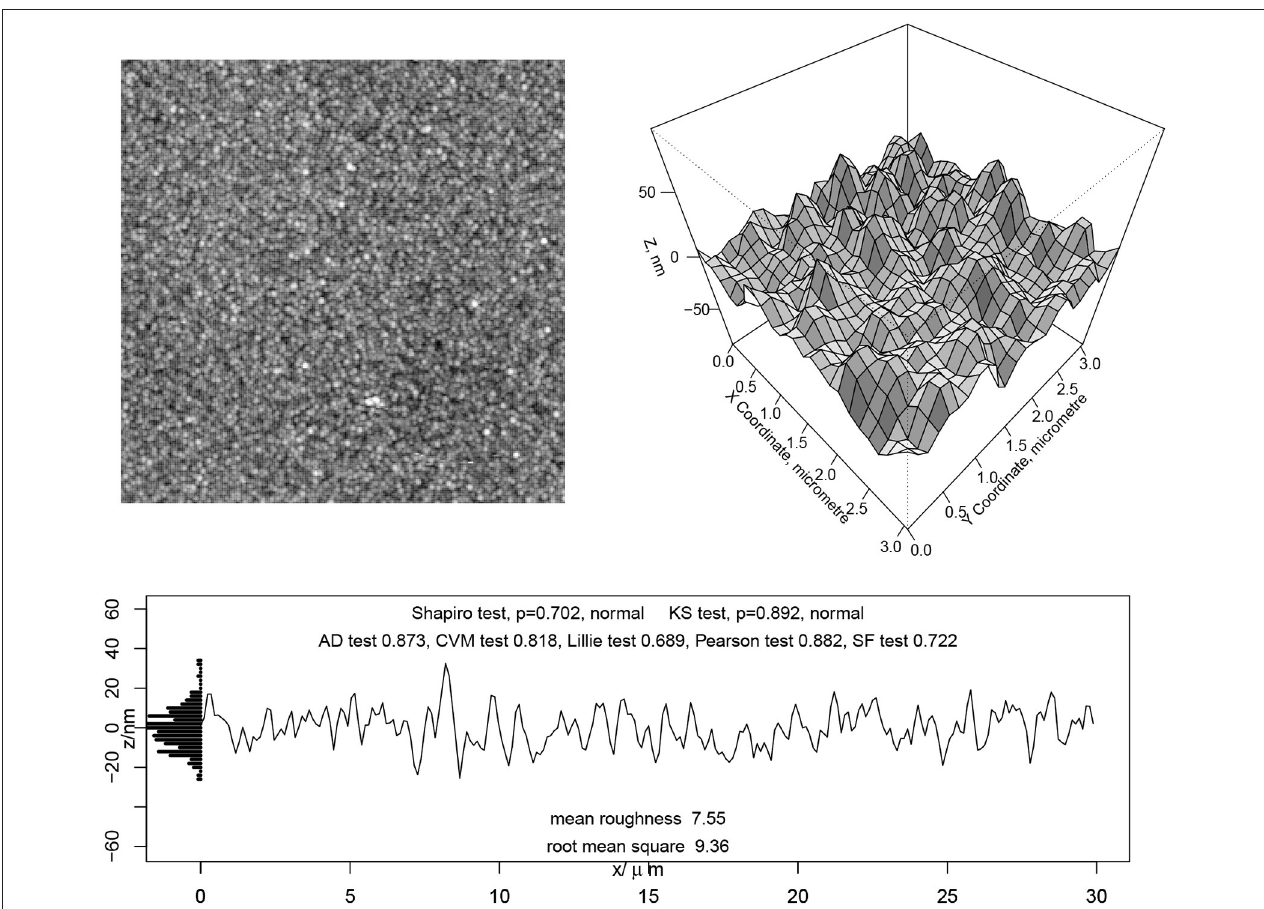
FIGURE 6 | The AFM scan of the a-C sample after profilometer measurements. (Left) full measured patch 30 x 30 µ m . (Right) extracted small region 3 x 3 µ m . (Bottom) A typical profile with normality tests and two descriptive statistics (values are in nm): the root mean square (rms) and the mean roughness.